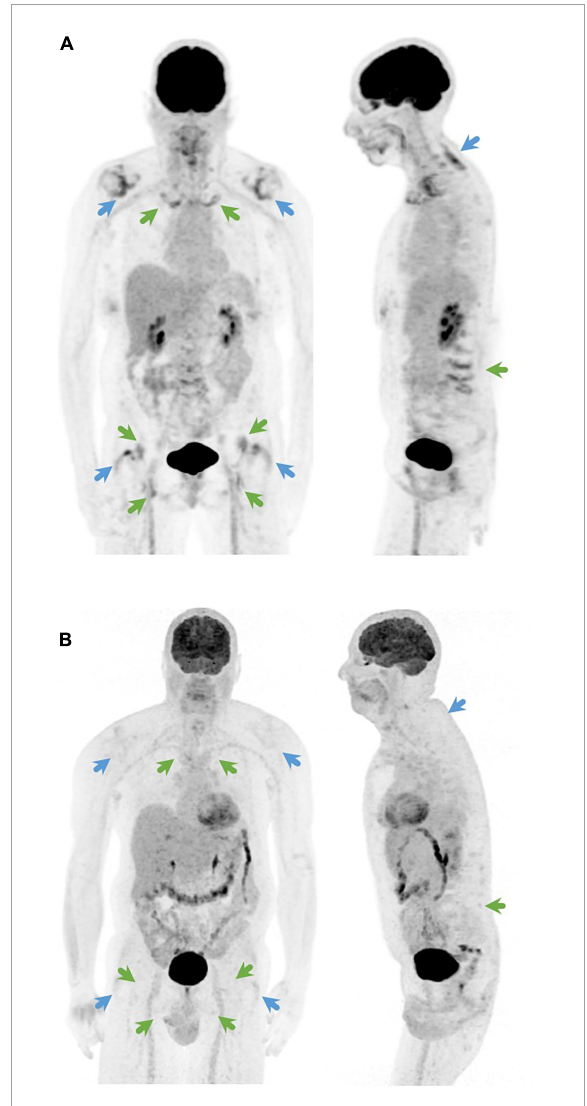
FIGURE1 Coronal (left) and sagittal (right) 18 F-FDG-PET image of (A) a PMR patient with a Leuven score of 24 and a Leuven/Groningen score of 14 and (B) a patient with fibromyalgia as final diagnosis with a Leuven score of 3 and a Leuven/Groningen score of 1. The Leuven score is the sum of joints indicated by green and blue arrows. The Leuven/Groningen score is the sum of joints indicated only by green